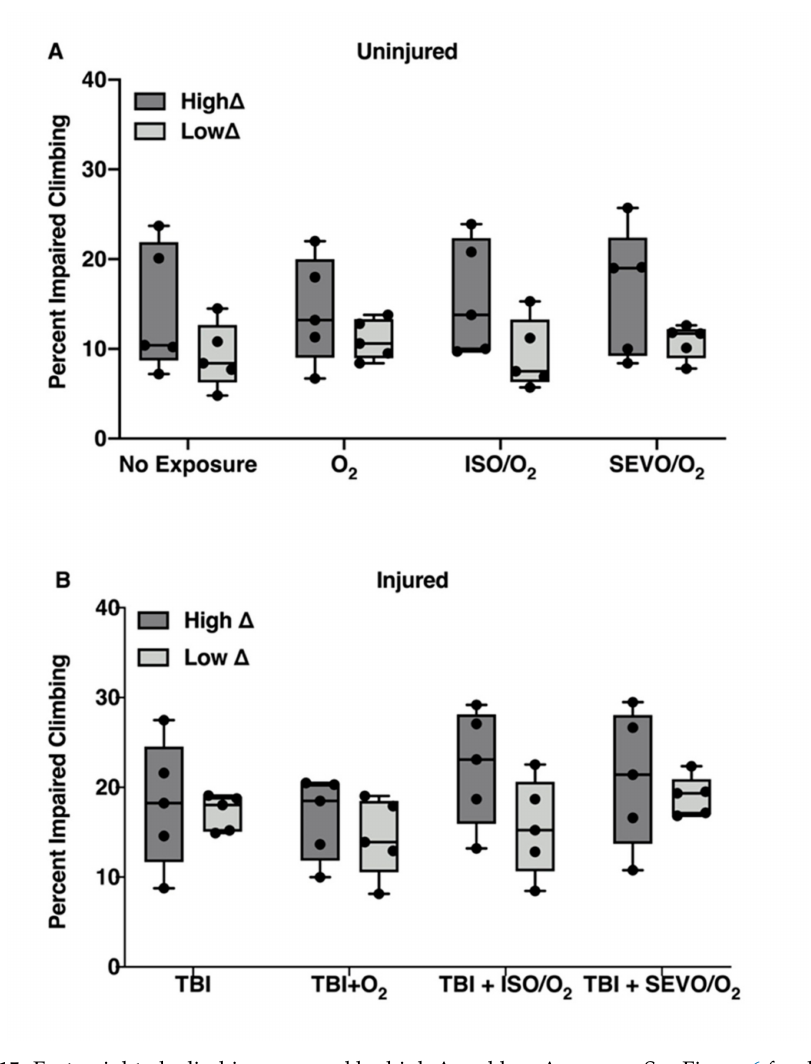
Figure A15. Forty-eighty h climbing grouped by high ∆ and low ∆ groups. See Figure 6 for details. ( A ) uninjured and ( B ) injured.